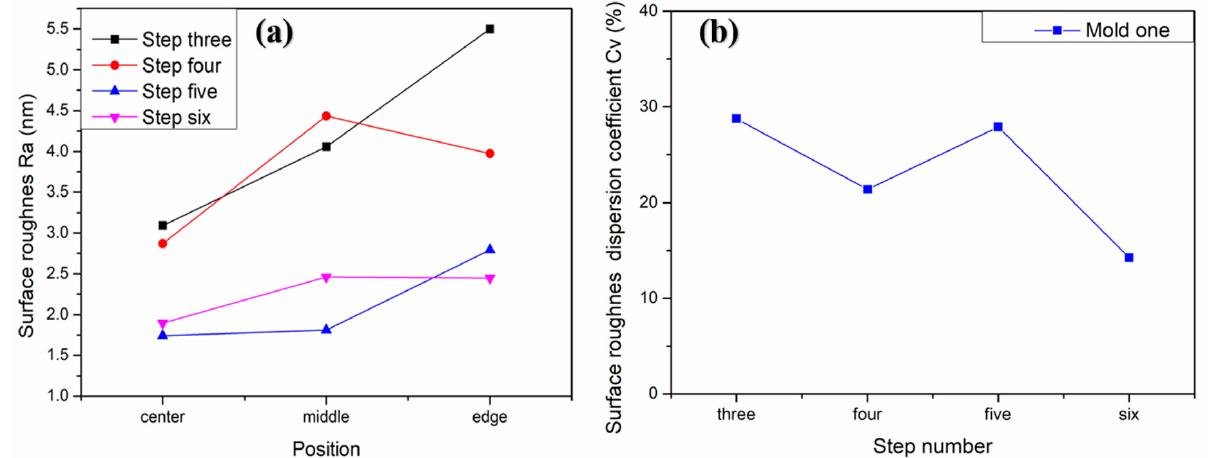
Figure 16. Mold one: ( a ) Comparison diagram of SR changes in the center, middle and edge of aspherical surface during polishing process; ( b ) Change diagram of SR dispersion coefficient.